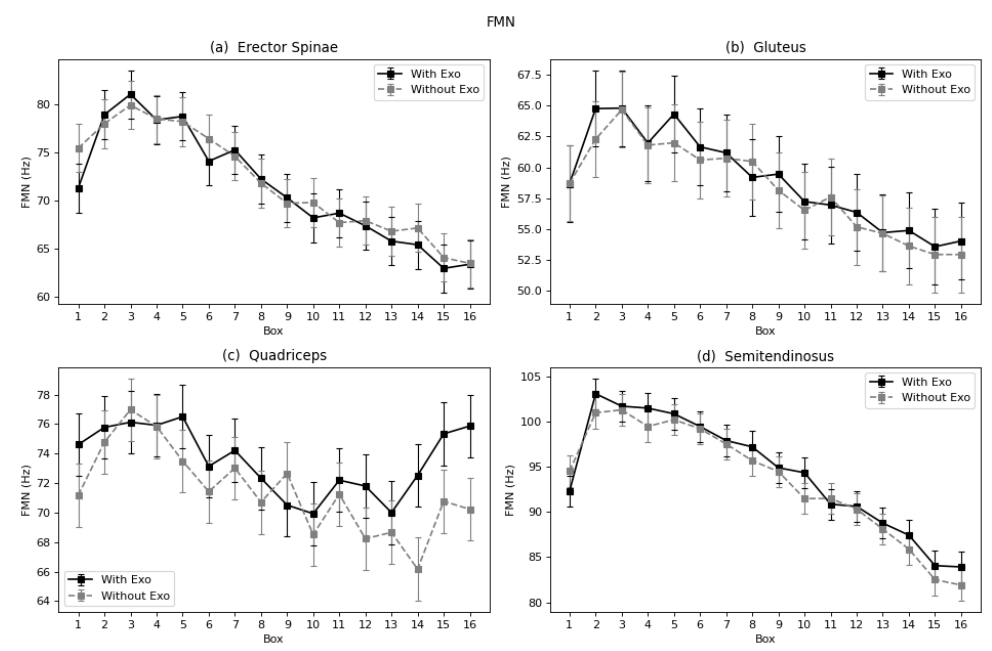
Figure 8. Marginal mean curves with the standard error bars of FMN parameter throughout the 16 boxes for all four muscles: ( a ) Erector Spinae, ( b ) Gluteus, ( c ) Quadriceps, and ( d )